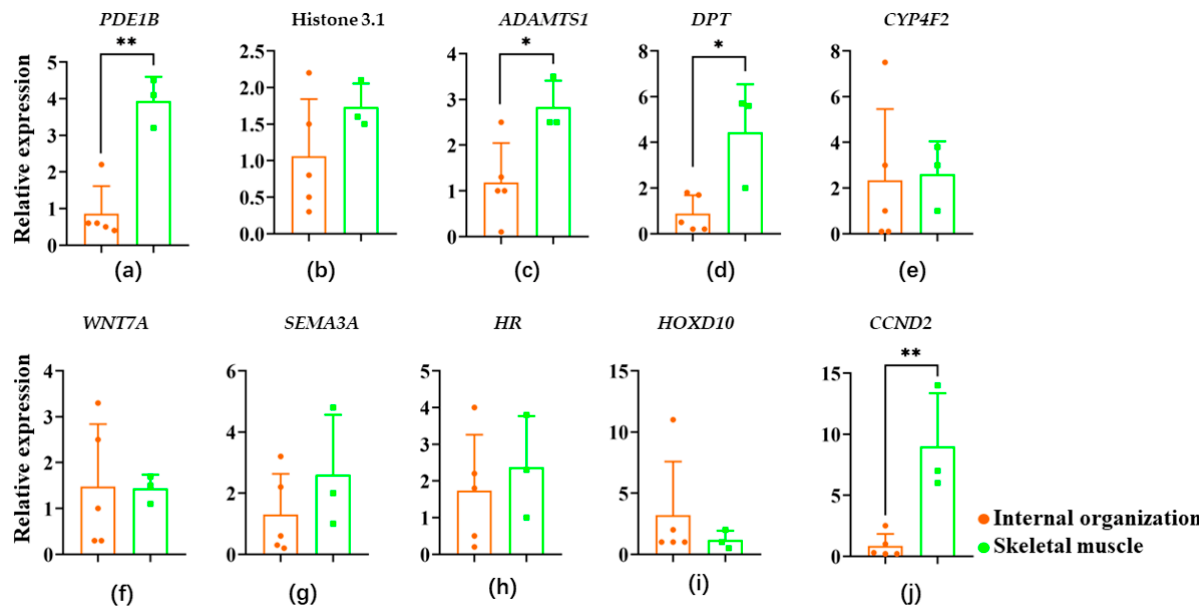
Figure 8. Quantification of mRNA expression levels in tissues of Guanling cattle. ( a ) PDE1B . ( b ) Histone 3.1. ( c ) ADAMTS1 . ( d ) DPT . ( e ) CYP4F2 . ( f ) WNT7A . ( g ) SEMA3A . ( h ) HR. ( i ) HOXD10 . ( j ) CCND2. * p < 0.05, ** p < 0.01.